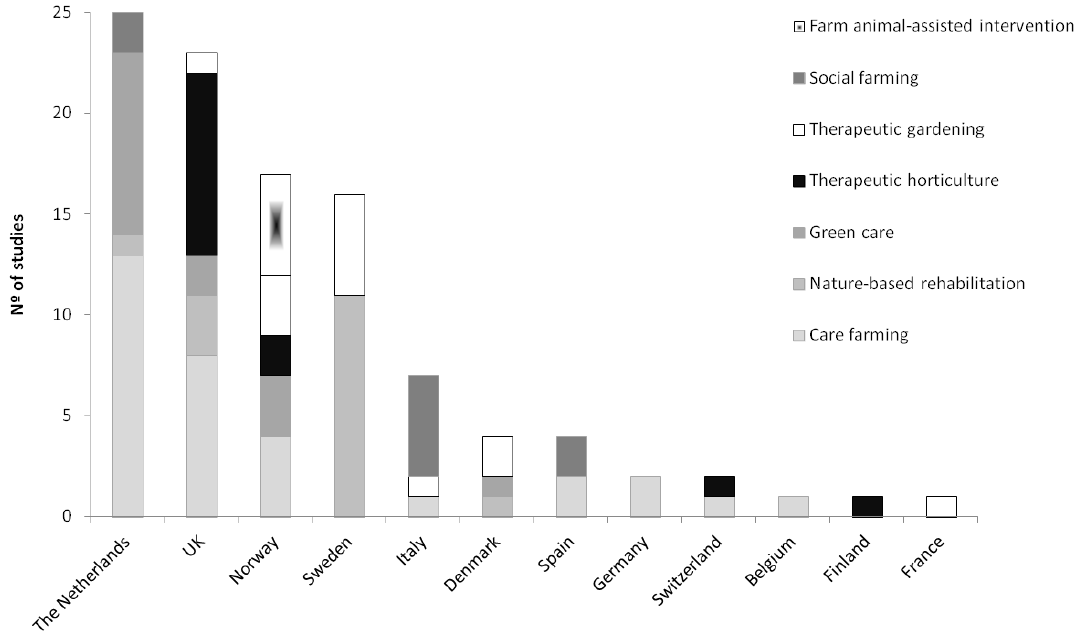
Figure 2. Number of publications per country, including the approach used.